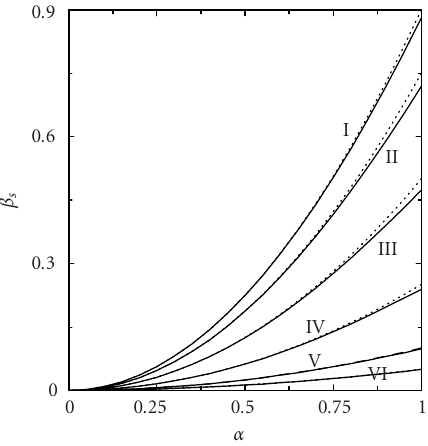
Figure 3.6. The variation of the smaller root β s of (3.10) as a function of the parameter α for various values of the nonintegrability parameter ν . Since λ = − 1, these states are staggered stationary localized states. Curve I: ν = 0 . 1, curve II: ν = 0 . 25, curve III: ν = 0 . 5, curve IV: ν = 0 . 75, curve V: ν = 0 . 90, and curve VI: ν = 0 . 95. Each curve is also associated as in Figure 3.2 with a dotted curve which shows the variation of α 2 (1+ ν λ ) as a function of α for the corresponding value of ν